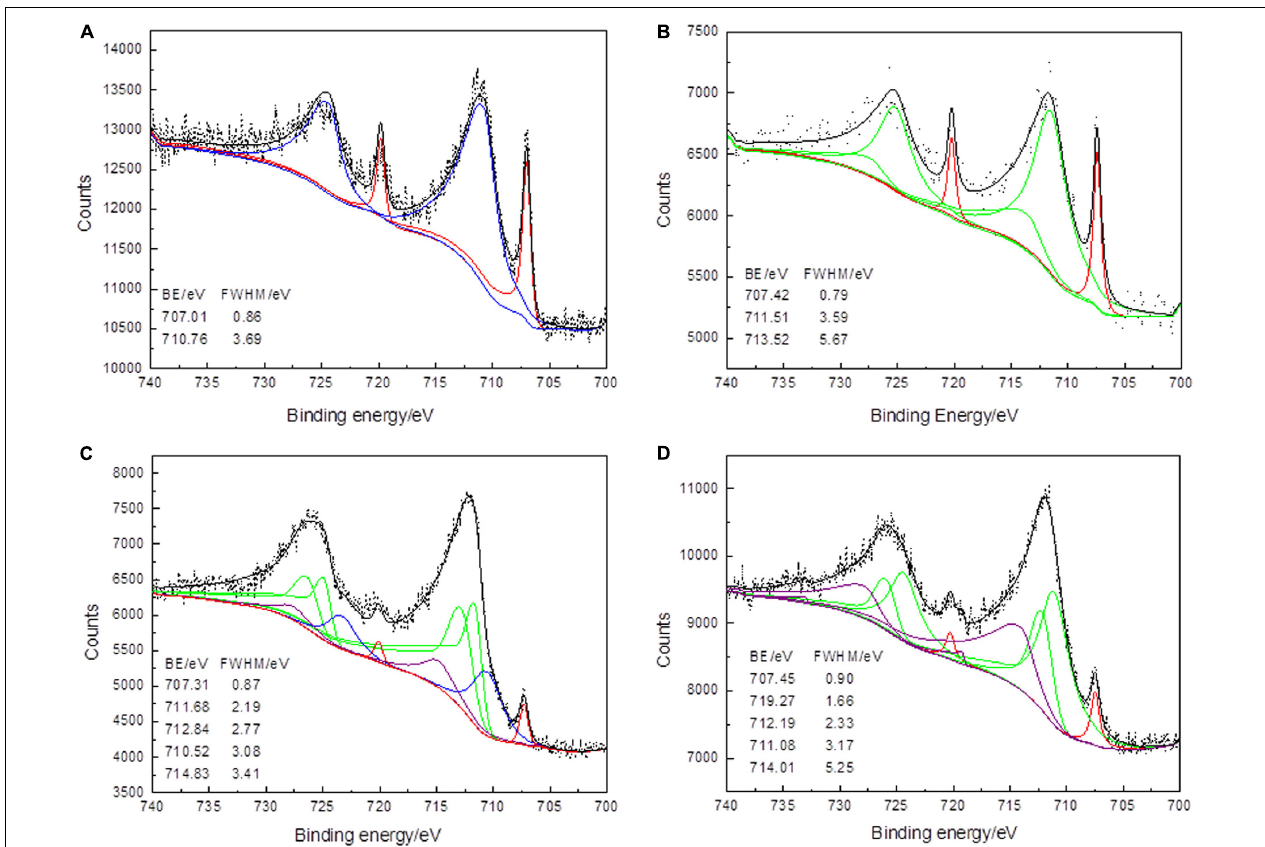
FIGURE 3 | XPS Fe 2p spectra of arsenopyrite before (A) and after bioleaching with mixed culture for 2 days (B) , 6 days (C) , and 10 days (D) at 45 ◦ C and initial pH 1.5. (Short dots – the experimental data. Fits to data – black The curves in red, blue, green, and purple present the spin-orbit split peaks of Fe(II) –(AsS), Fe(III) –(AsS), Fe(III) –OH, and Fe(III)